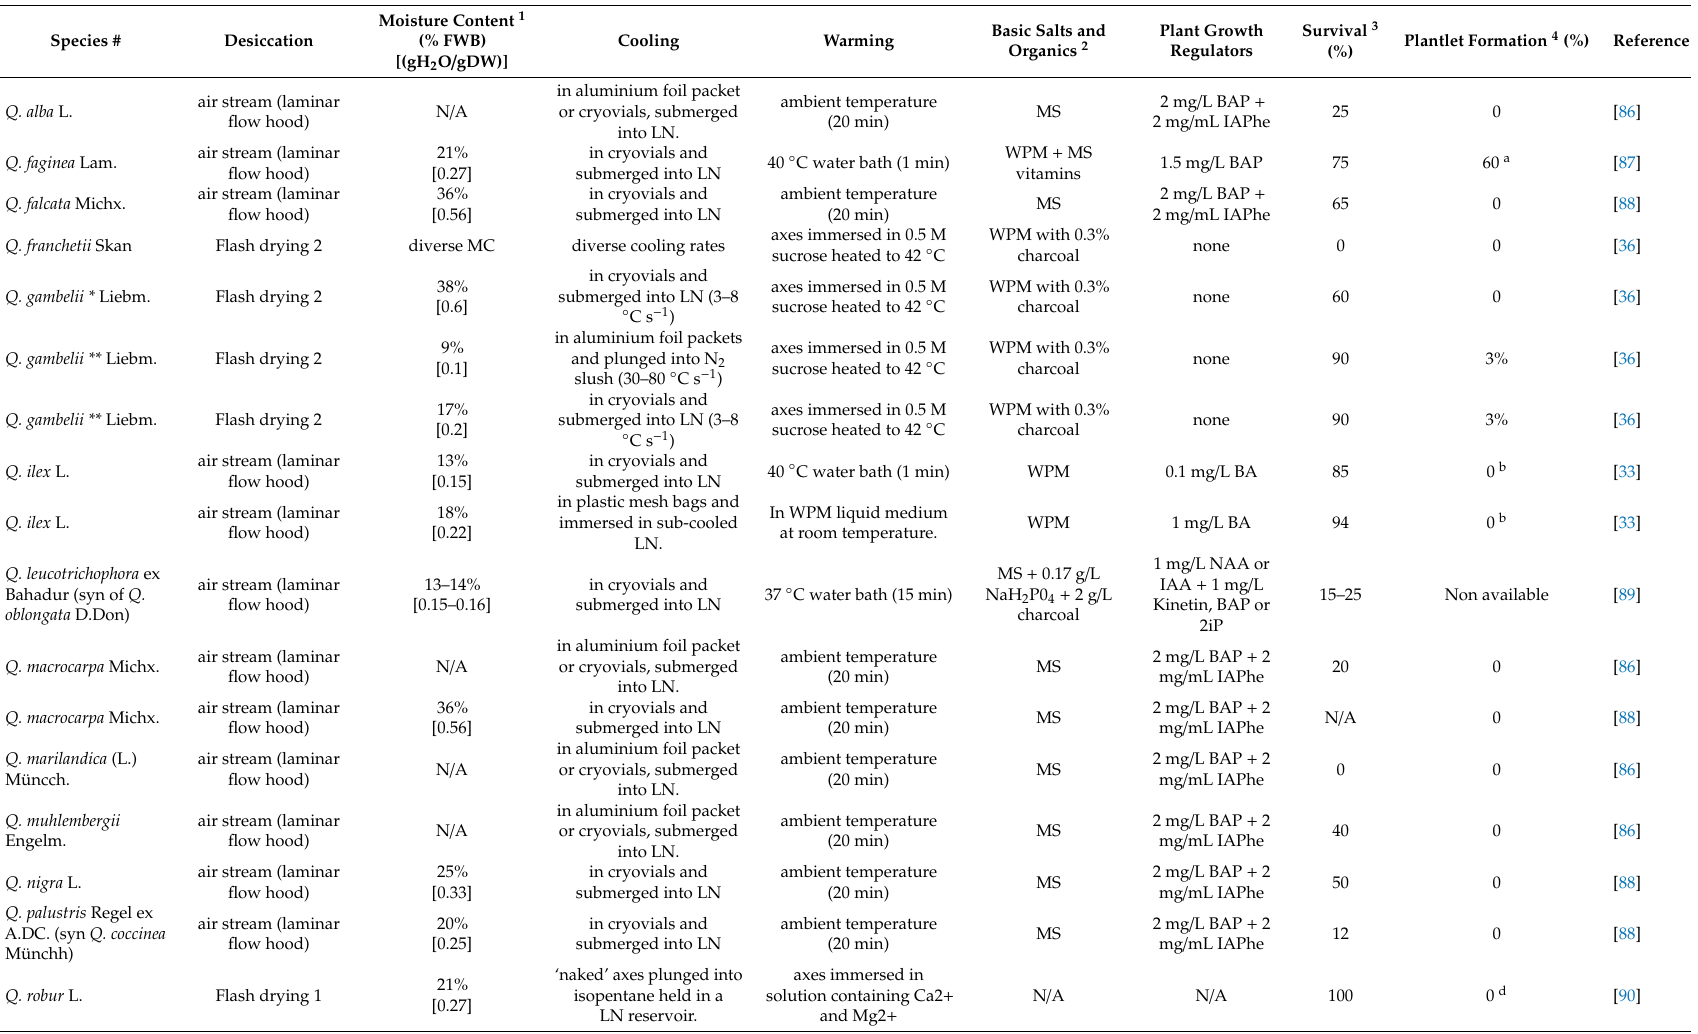
Table 2. Cryopreservation successes with embryonic axes of Quercus